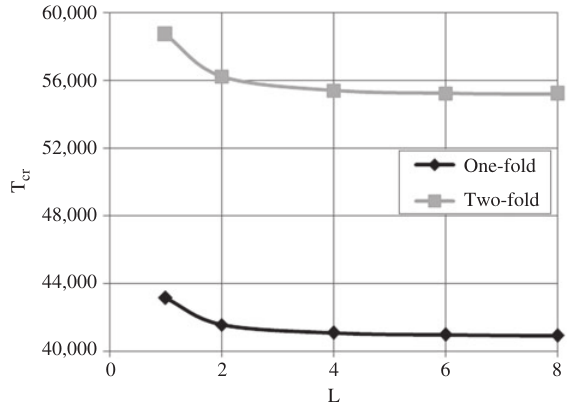
Figure 6 Effect of plate length on the critical thermal buckling load for one-fold and two-fold laminated